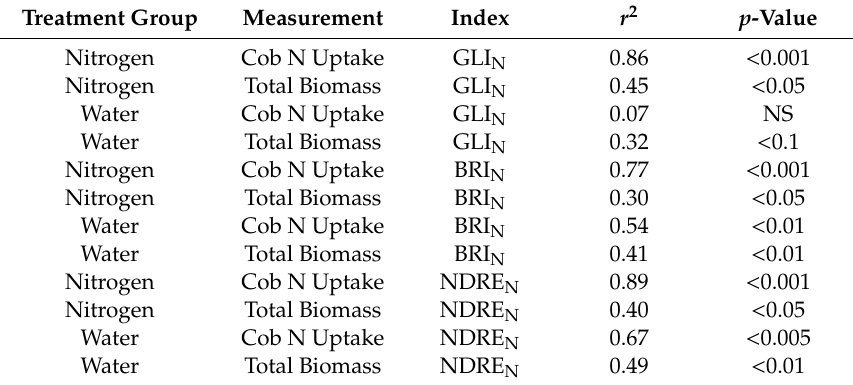
Table 3. Anova results relating the normalized multi-spectral indices green leaf index (GLI N ), blue reflectance index (BRI N ) and normalized di ff erence red-edge (NDRE N ) to total biomass production or cob N uptake for the experimental site at R2 using Equation (8). NS = not significant at α = 0.05, r 2 = coe ffi cient of determination.